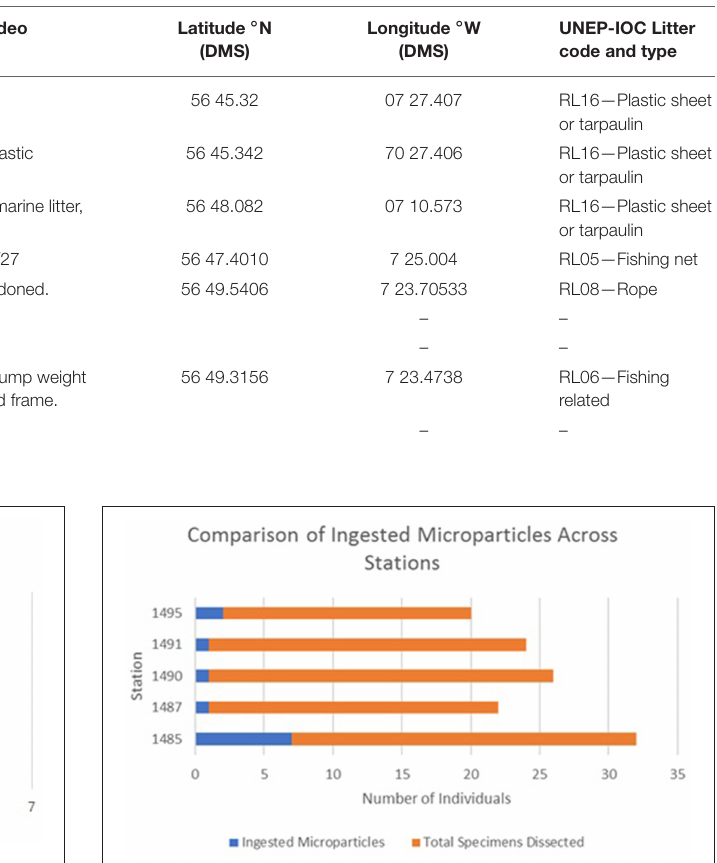
FIGURE 3 | Number of ingested microparticles across stations shows how many individual specimens were found to have ingested microparticles out of all the specimens